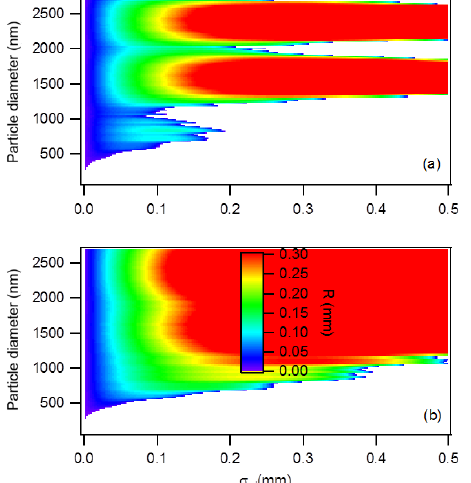
Figure 9. Model of the effective detection beam radius as a func- tion of particle size and collimated beam waist size. (a) A detection system comprising 300mW and a wavelength of 532nm, with light collection 10–12 ◦ , and (b) a detection system comprising equally mixed 532 and 808nm laser sources.